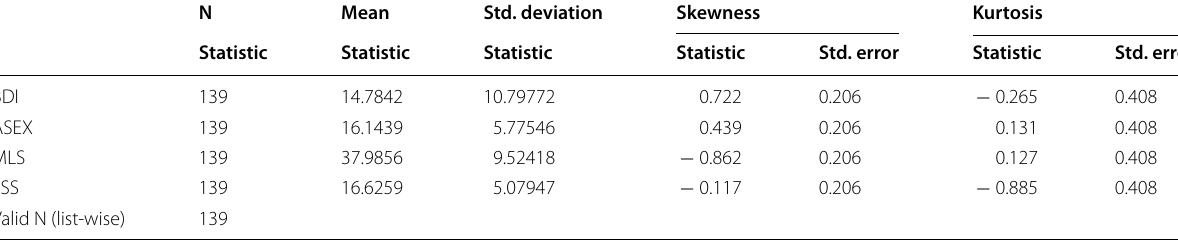
Table 3 Descriptive statistics of scales